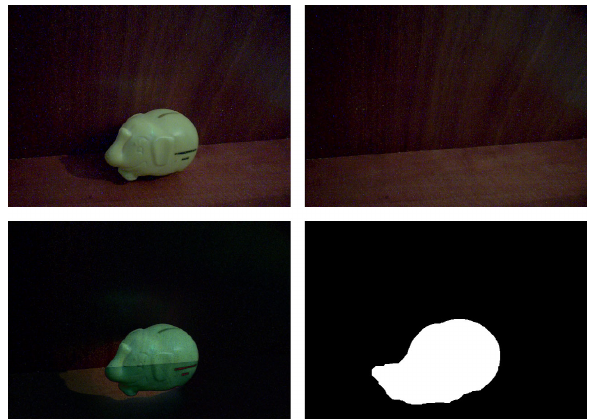
Figure 2. Above: reference image (left) and background planes (right). Below: subtraction of these images (left) and silhouette of the object (right), which includes its shadow.